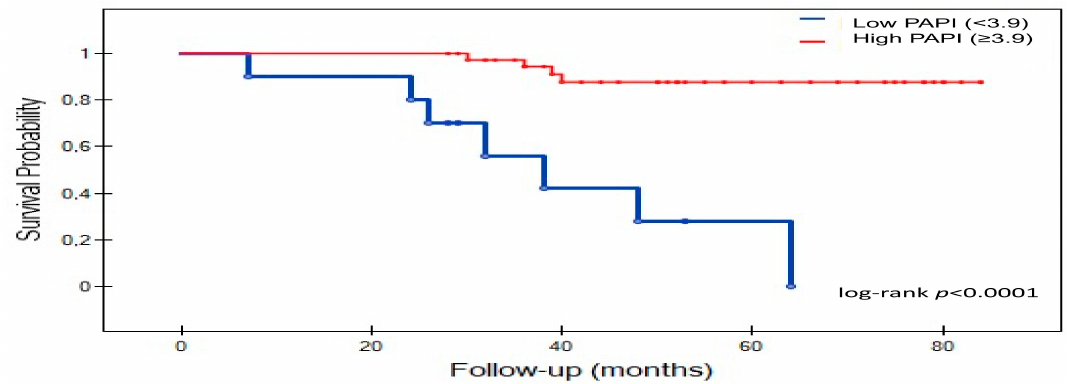
Figure 2. Kaplan − Meier survival curves analysis for low and high-PAPI group. Abbreviations: PAPI, pulmonary artery pulsatility index.